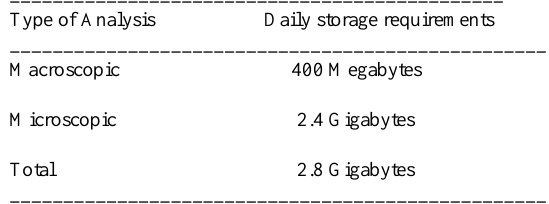
Table 1. Storage space requirements at I-94 section